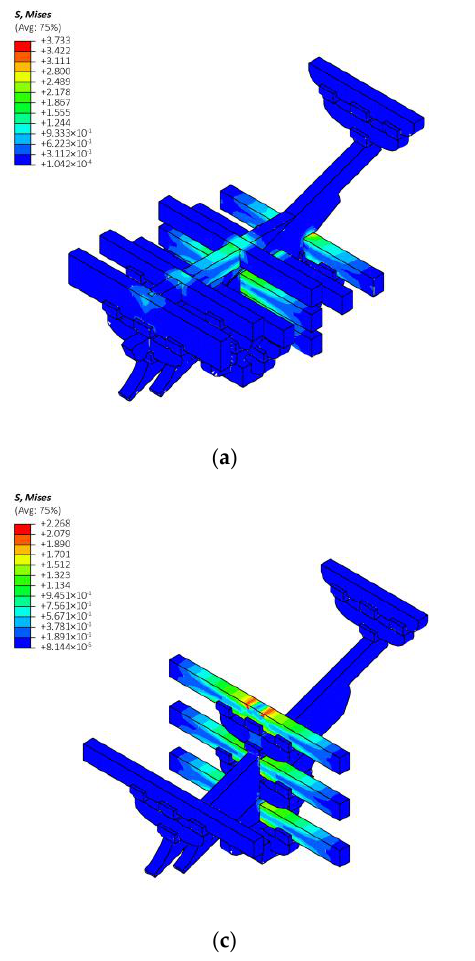
Figure 16. Mises stress of the Dou-gongs in the collapse case, refined model vs. simplified model (unit: MPa): ( a ) refined model, Ji-xin-zao Dou-gong; ( b ) simplified model, Ji-xin-zao Dou-gong; ( c ) refined model, Tou-xin-zao Dou-gong; ( d ) simplified model, Tou-xin-zao Dou-gong. Then, the vertical stiffness of the refined and simplified models is also